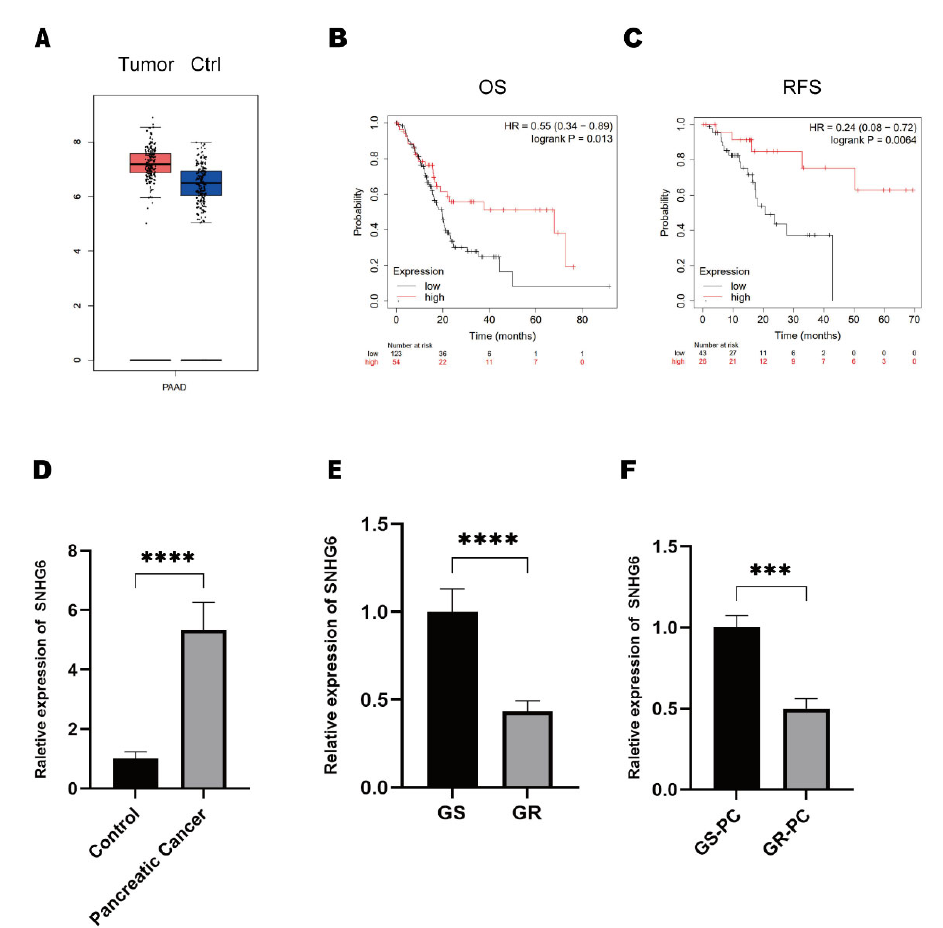
Figure 1. LncRNA SNHG6 is dysregulated in PC. ( A ) Expression of LncRNA SNHG6 in PC, analyzed by the online toolkit GEPIA while LncRNA SNHG6 and pancreatic cancer were made inquiries. ( B ) The correlation of LncRNA SNHG6 and the overall survival rate of PC patients were analyzed by the online database Kaplan–Meier plotter; OS, overall survival; RFS, recurrence ‐ free survival; HR, hazard ratio. ( C ) The correlation of LncRNA SNHG6 and the recurrence ‐ free survival rate of PC patients. ( D ) The expression of LncRNA SNHG6 in the resected PC tissues and para ‐ carcinoma tissues (control), quantified by RT ‐ PCR, n = 3, ****, p < 0.0001. ( E ) RNA level of LncRNA SNHG6 in GEM ‐ resistant (GR) and the GEM ‐ sensitive (GS) PANC ‐ 1 cells, quantified by RT ‐ PCR, n = 3, ****, p < 0.0001. ( F ) Expression level of LncRNA SNHG6 in the resected PC tissue from GEM ‐ resistant PC patients (GR ‐ PC) and GEM ‐ sensitive PC patients (GS ‐ PC), n = 3, ***, p < 0.001.